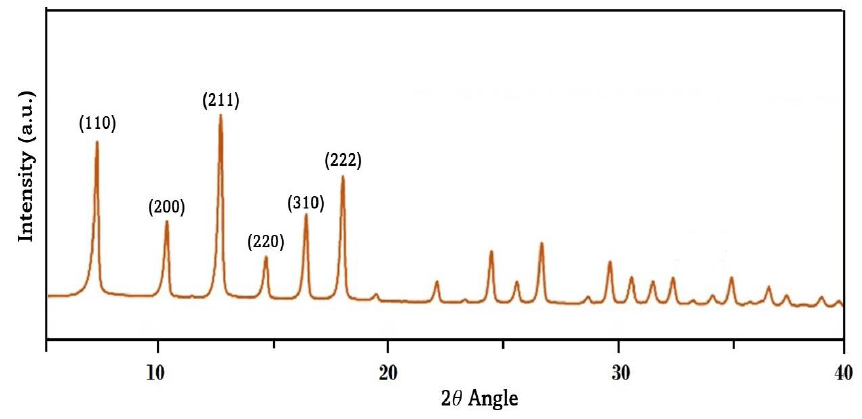
Figure 3. XRD pattern of synthesized ZIF-8.